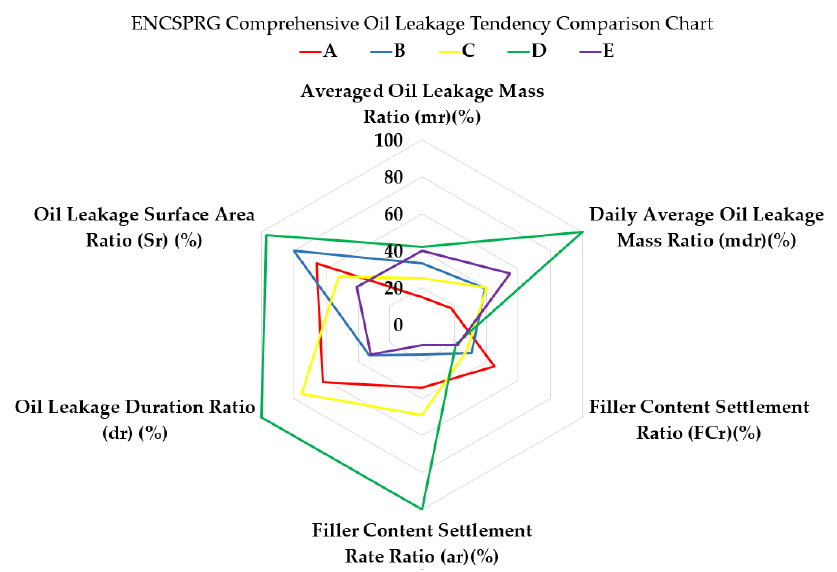
Figure 12. Comprehensive illustration of the evaluation results of the five ENC-SPRG specimens.